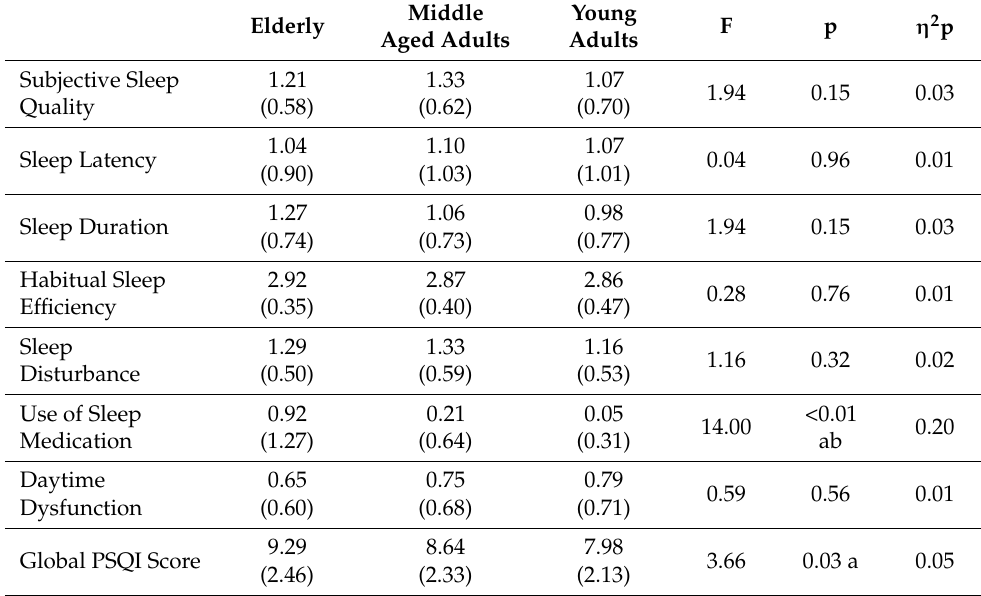
Table 2. Between-group comparisons of sleep characteristics (Pittsburgh Sleep Quality Index). Elderly